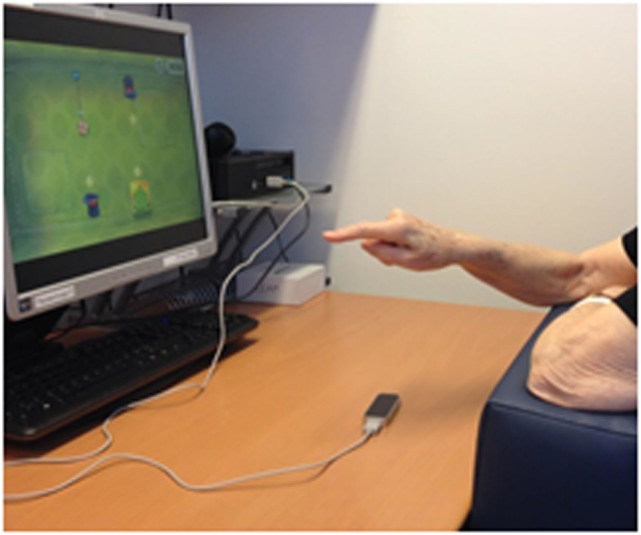
Research setup. Courtesy of S. Filius.